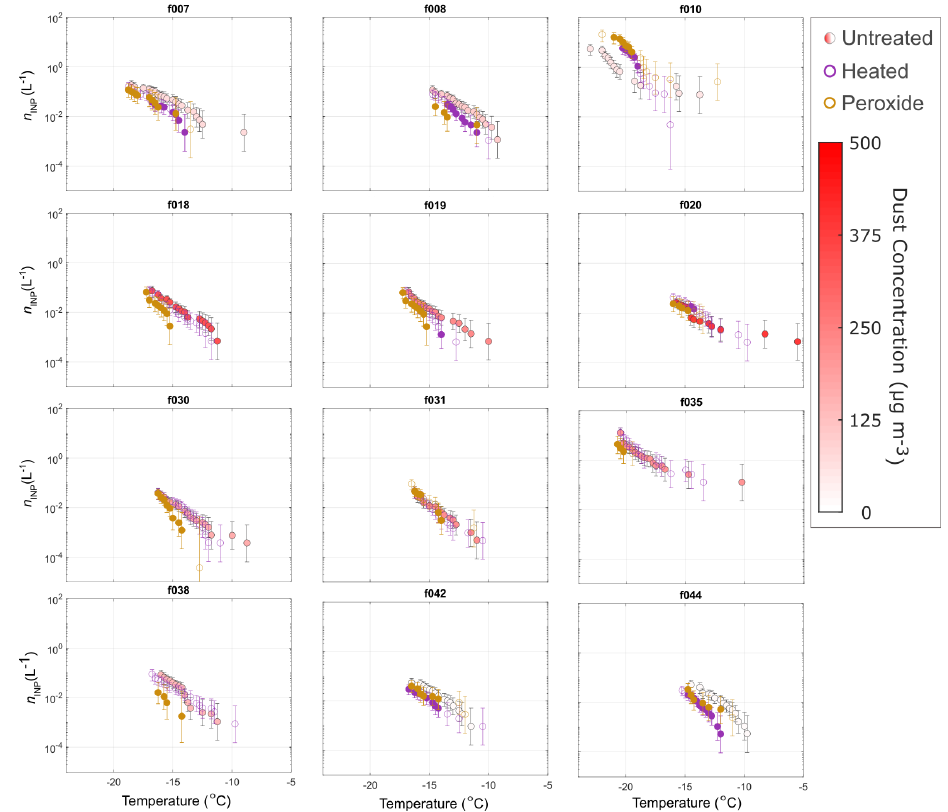
Figure 5. INPs in aerosol samples treated with heat and peroxide (Methods Sect. 2.4) to test for INP heat lability and organic composi- tion. Markers of untreated spectra are colored by the average dust concentration during the sampling period. Markers of heat-treated and peroxide-treated samples are filled to indicate significant INP concentration difference from untreated samples according to Fisher’s exact test ( p< 0 . 05). Sensitivity to peroxide is evident for all samples ≥ − 15 ◦ C, indicative of stable organic INPs. Heat lability is also evident at high to moderate temperatures in multiple samples, demonstrating that biological (e.g., proteinaceous) INPs also contributed to INPs observed during